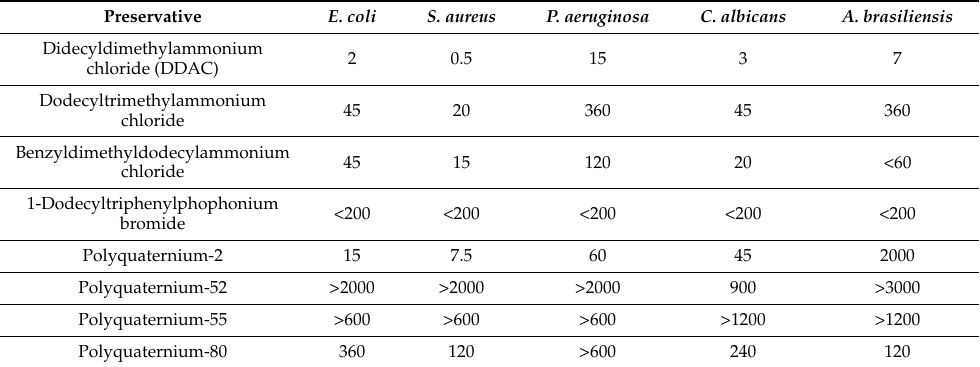
Table 1. MIC (minimum inhibitory concentration) values (expressed in ppm) of cationic surfactants against Escherichia. coli , Staphylococcus aureus , Pseudomonas aeruginosa , Candida albicans and Aspergillus brasiliensis microorganisms. Preservative E.